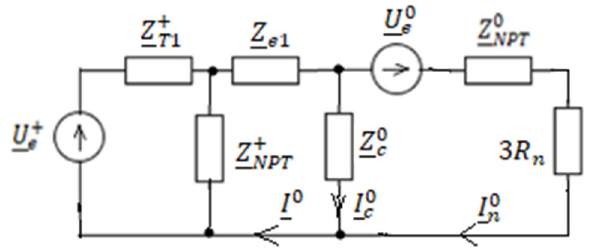
Figure 5. Scheme for calculating the zero-sequence current of the capacitive current of the 20 kV network.